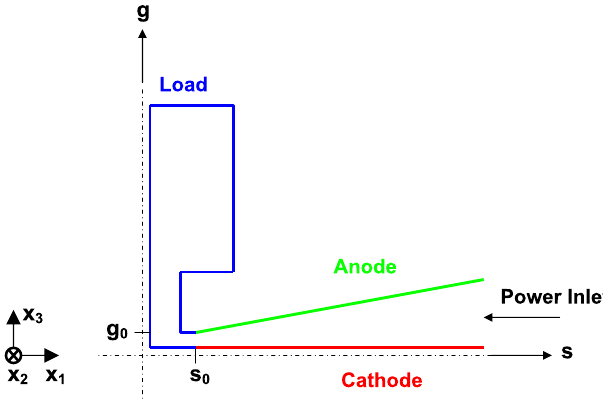
FIG. 1. (Color) Inductively loaded MITL with spatially varying A-K gap profile. This configuration is cylindrically symmetric about either the ^ g or ^ s axis depending upon the intended geometry. A radial disk configuration would be generated by revolving the ^ s axis about the ^ g axis such that ð x 1 ; x 2 ; x 3 Þ ! ð r; (cid:1); z Þ for a cylindrical curvilinear coordinate system. For a coaxial line, the ^ g axis is revolved about the ^ s axis such that Þ ! ð z; (cid:6) (cid:1); r Þ ; the gap spacing in this case is defined as ð x 1 ; x 2 ; x 3 the difference between the radius at the edge of the anode and the radius at the edge of the